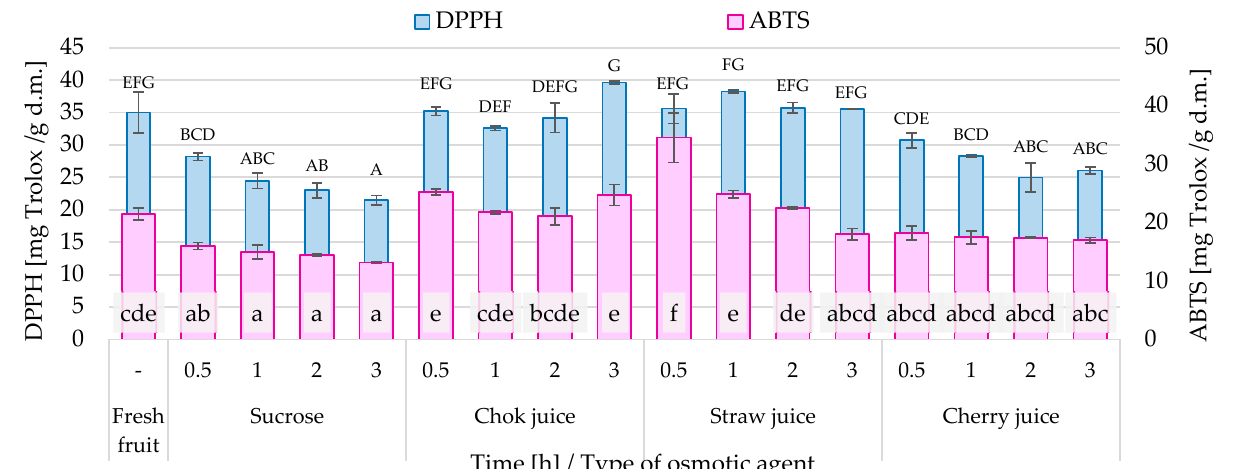
Figure 7. Effect of the type of osmotic agent (sucrose and fruit concentrates) on the antioxidant activity of osmodehydrated strawberries. Different letters (small letters are for antioxidant activity according to ABTS radical, capital letters are for antioxidant activity according to DPPH radical) above columns show the statistical difference ( p <